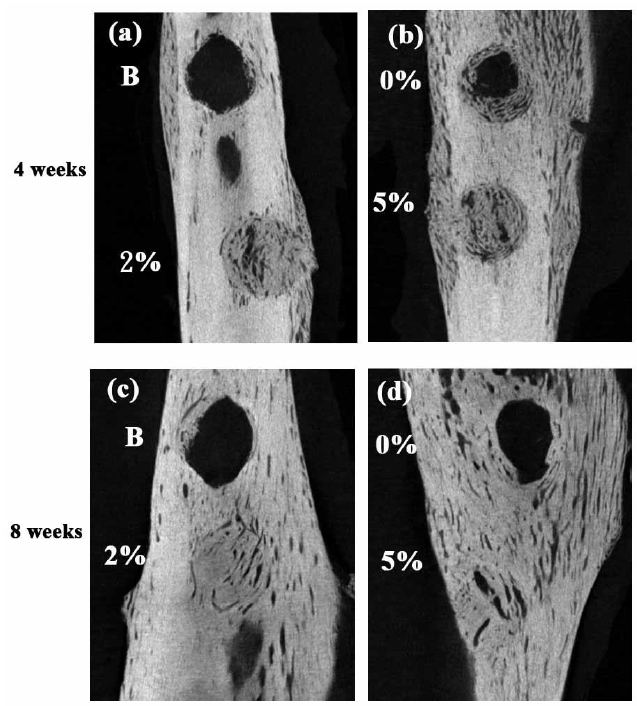
Figure 6. Micro-CT images of artificial defects after four weeks ( a , b ) and eight weeks ( c , d ). ( a , c ) show blank control (upper defects) and 2% Fe 3 O 4 /PLLA nanofiber-filled samples (lower defects), respectively; ( b , d ) show neat PLLA (upper defects) and 5% Fe 3 O 4 /PLLA (lower defects) nanofiber-filled samples, respectively.